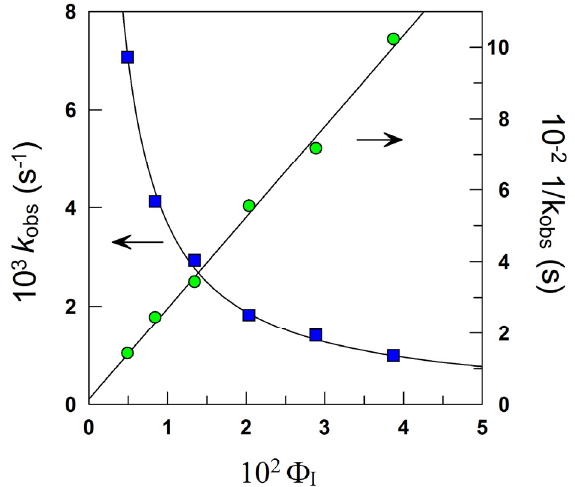
on k for the reaction of 16-ArN 2+ with resveratrol in Figure 3. Effects of increasing Ф I obs 4:6 stripped corn oil/Tween 20/acidic water emulsions. Experimental conditions: [16-ArN 2+ ] = 1.034 × 10 − 4 M, [RES] = 1.3 mM, pH 2.14 (citrate buffer 0.04 M), [NED] 0.02 M, T = 25